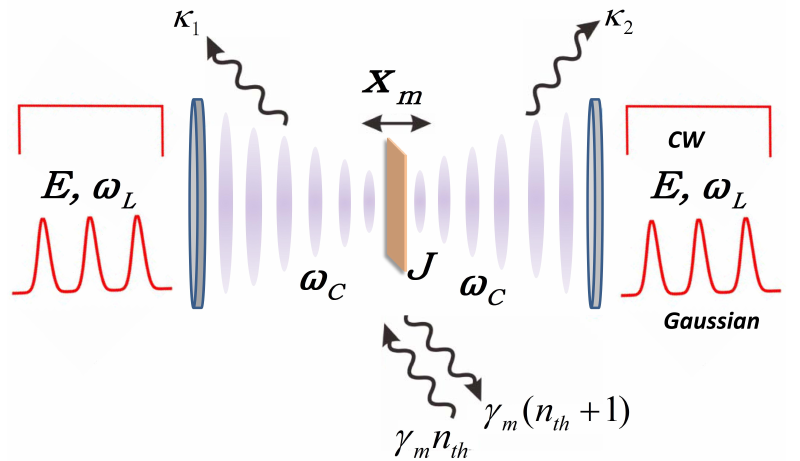
Figure 1. The setup of a membrane-in-middle optomechanical system. A thin membrane is inserted into an optical cavity, and it acts as a mechanical resonator. The system is driven by Gaussian pulses, a continuous-wave field, or both, respectively, on the left and right side, thus creating radiation pressure on the